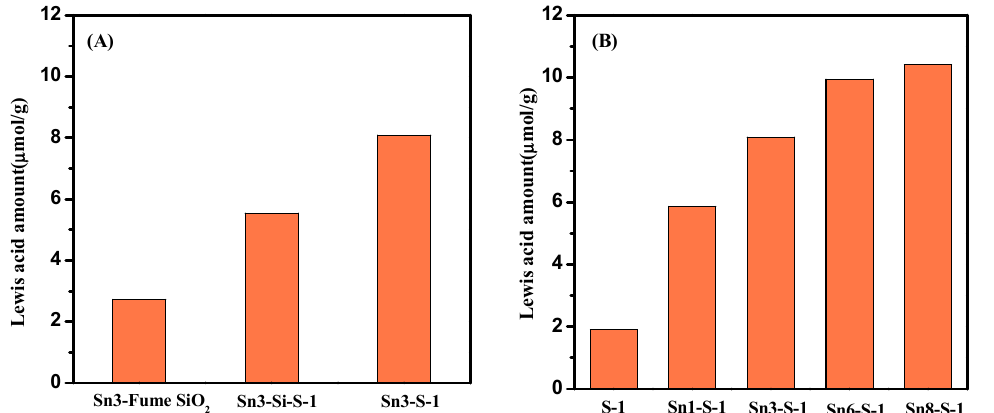
Figure 8. Dependences of the number of Lewis acid sites (estimated with the 1455 cm − 1 band of pyridine adsorption FT-IR spectra after evacuation at 350 °C, following the procedures reported in [39,40]) of the Sn-containing catalysts on matrix ( A ) and Sn loading ( B ).